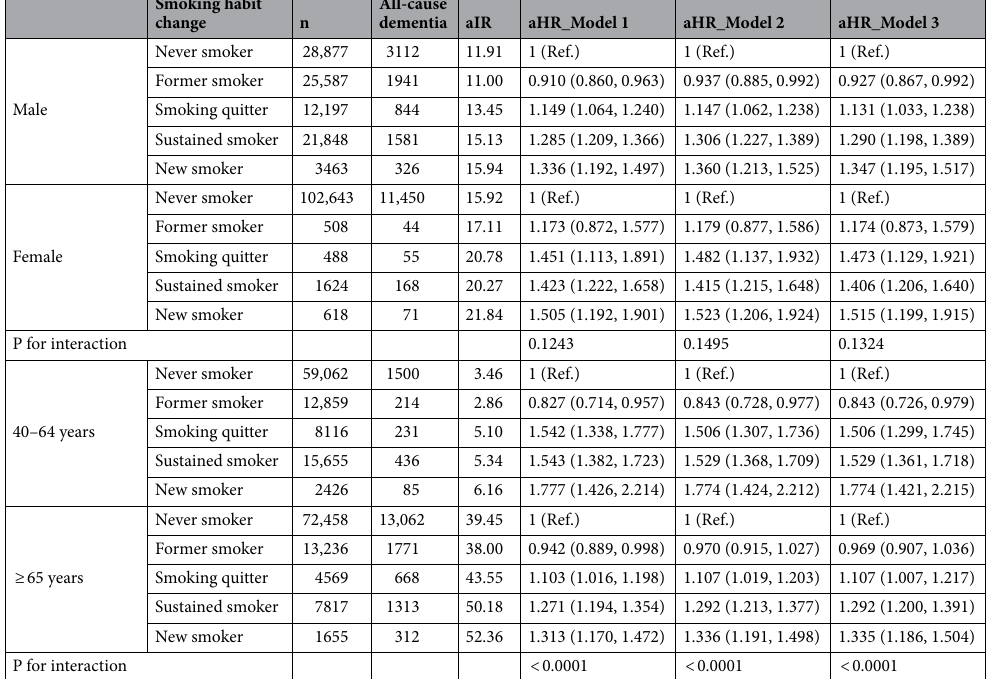
Table 3. Subgroup analyses according to the age and sex group and risk for all-cause dementia. HR hazard ratio, aHR adjusted hazard ratio, IR incidence rate; PY